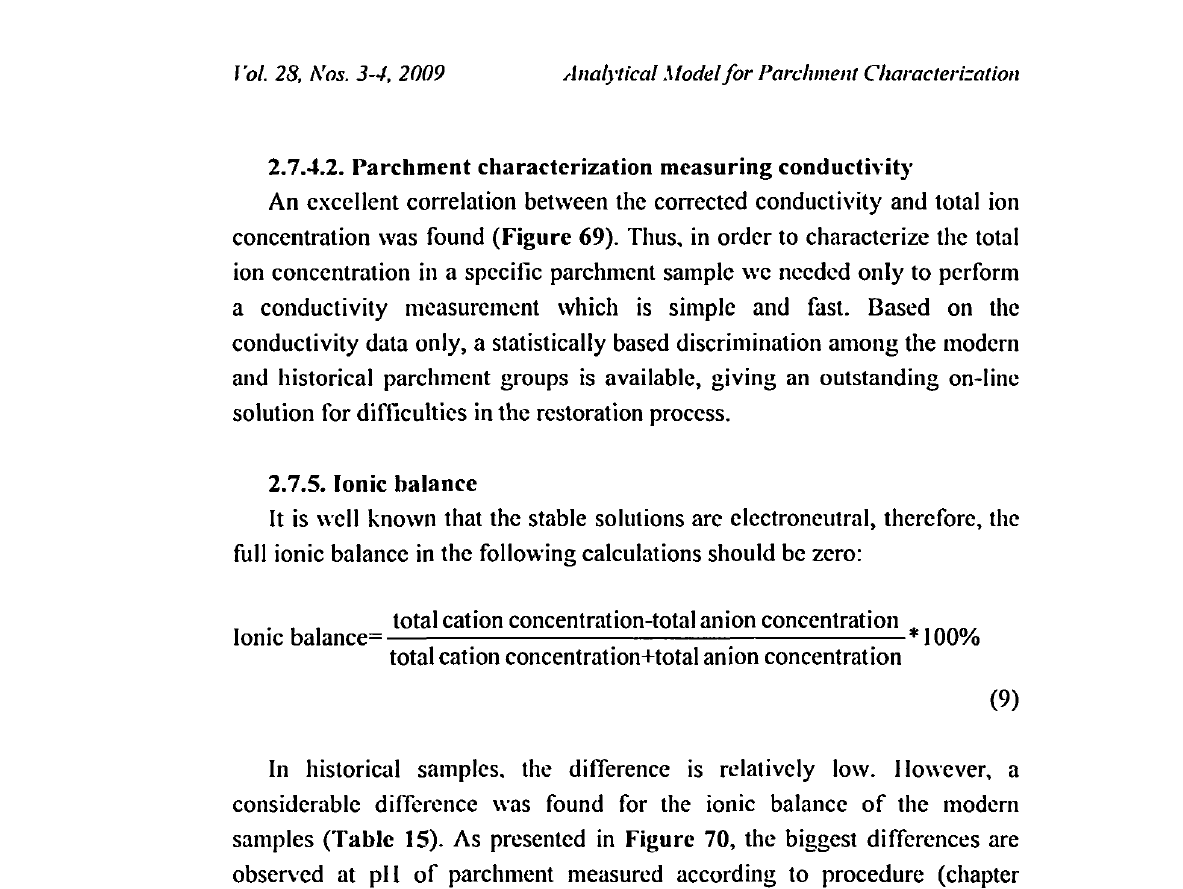
Ionic balance in parchment